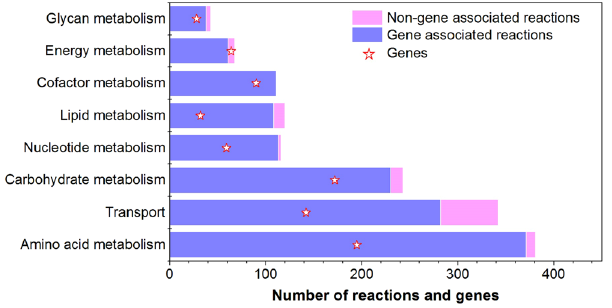
Figure 1. Distribution of genes and reactions across major metabolic sub-systems in i